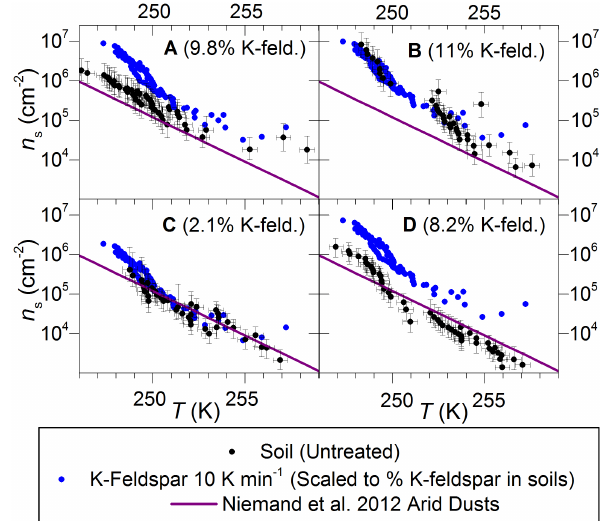
Fig. 4. Ice active site densities ( n s ) values determined from nano- litre drop freezing experiments for soils A–D. Each graph shows the data selected from at least 2 droplet size bins, as outlined in Sect. 2.4. The feldspar data are for K-feldspar at the same cooling rates (d T /d t = − 10Kmin − 1 ) as used for the soils. The K-feldspar n s has been scaled down according to the feldspar mass fraction in each of the soils (see Sect. 3.1). Also shown is the parameterisation for arid dusts, as provided by Niemand et al.